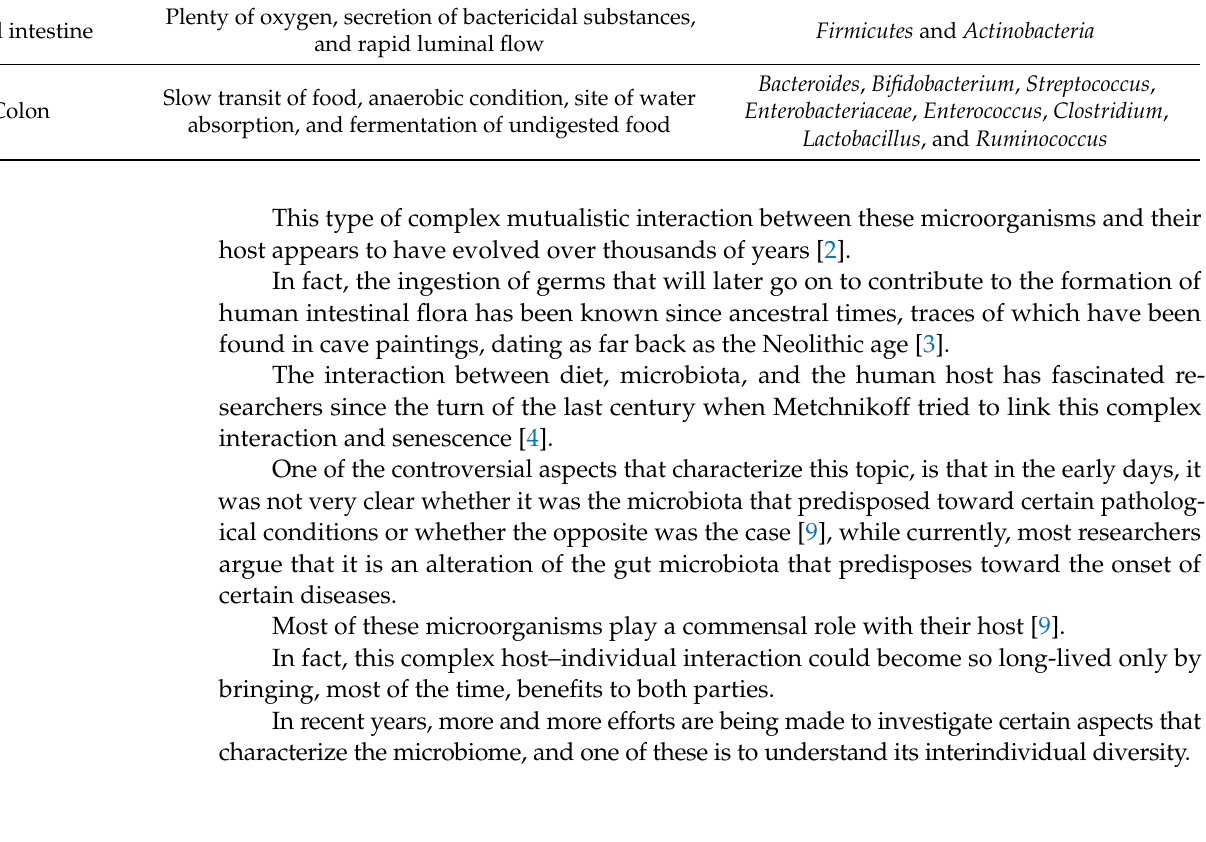
Table 1. Summary of the predominant microorganisms in the various tracts of the digestive system with their basic